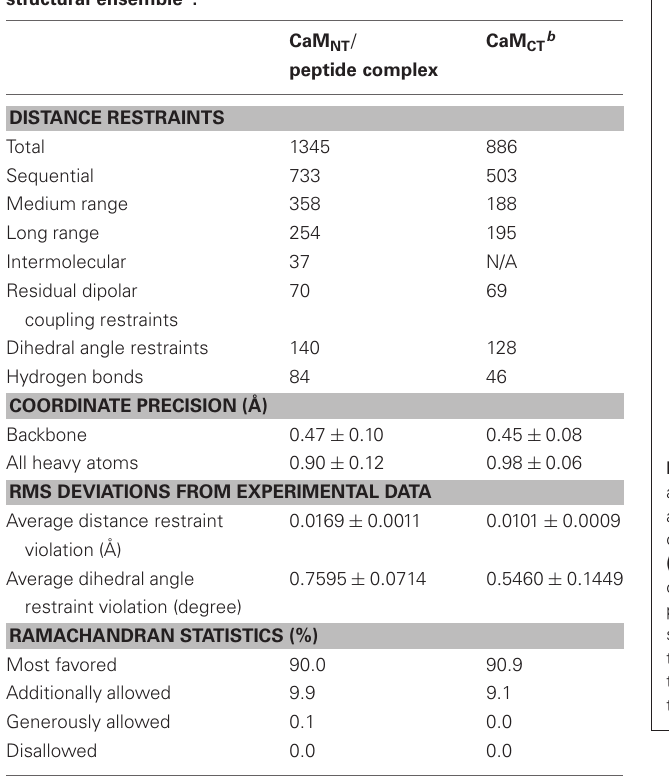
Table 2 | Statistics for the Ca 2 + -CaM/Ca v 1.2NT NSCaTE peptide structural ensemble a .